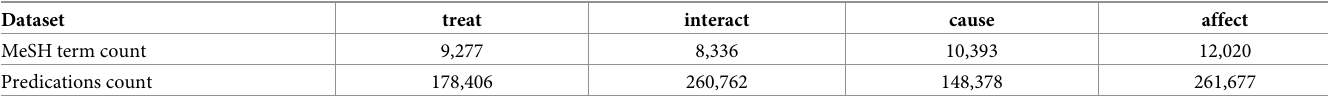
Table 3. The four semantic predications datasets and their